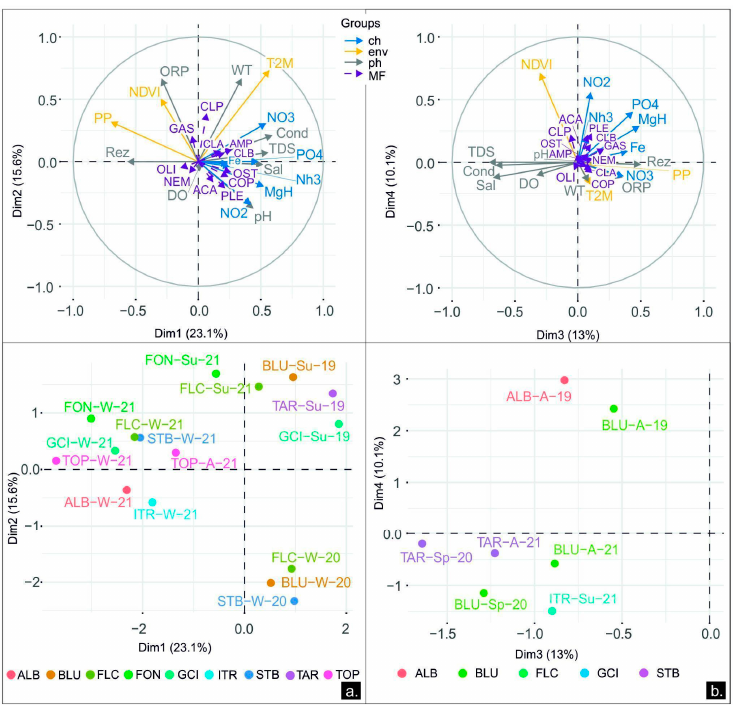
Figure 8. Representation of the contribution of physical, chemical, and environmental parameters to the profile of the freshwater sites, based on fauna on the first four dimensions resulting from MFA analysis: (a) dimensions 1 and 2; (b) dimensions 3 and 4. Vectors correspond to the active groups of variables (physical, chemical, and environmental parameters) and to the supplementary group of variables (meiofauna, MF) that did not contribute to the construction of dimensions. The three-letter acronyms correspond to sampled freshwater sources (see Table 1); Sp = spring, Su = summer, A = Autumn, W = winter; 19 = year 2019, 20 = year 2020, 21 = year 2021. Fauna groups are abbreviated as follows: ACA = Acariformes, AMP = Amphipoda, BAT = Bathynellacea, BIV = Bivalvia, CLA = Cladocera, COL = Coleoptera, COP = Copepoda, DIP = Diptera, GAS = Gastropoda, LEP = Lepidoptera, OLI = Oligochaeta, OST = Ostracoda, PLE = Plecoptera, and TRI = Trichoptera. Only samples that were projected better than 0.5 cos 2 on the four axes are listed.